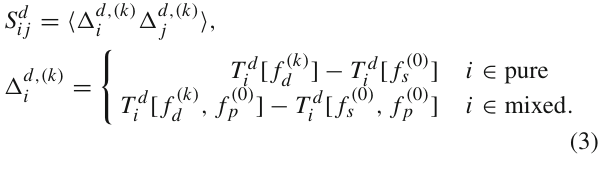
matrix is added to the experimental covariance matrix of the mixed deuteron data when performing the deuteron fit, to take account of the uncertainty of the proton PDF in the determination of the deuteron